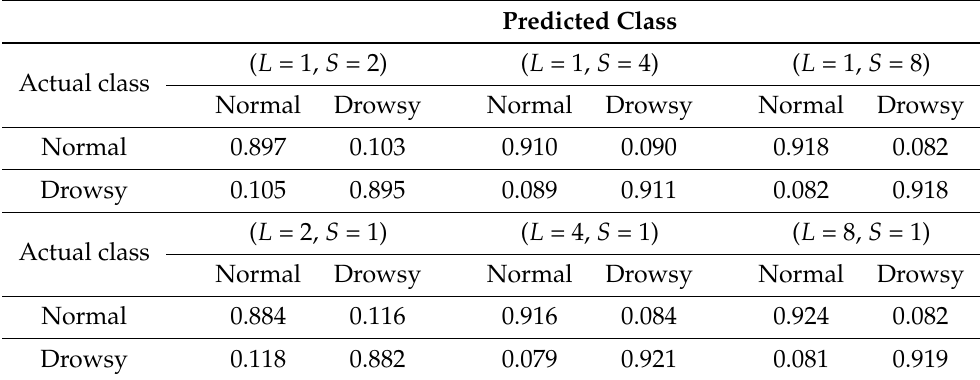
Table 8. Normalized confusion matrix of the proposed network with an asymmetric